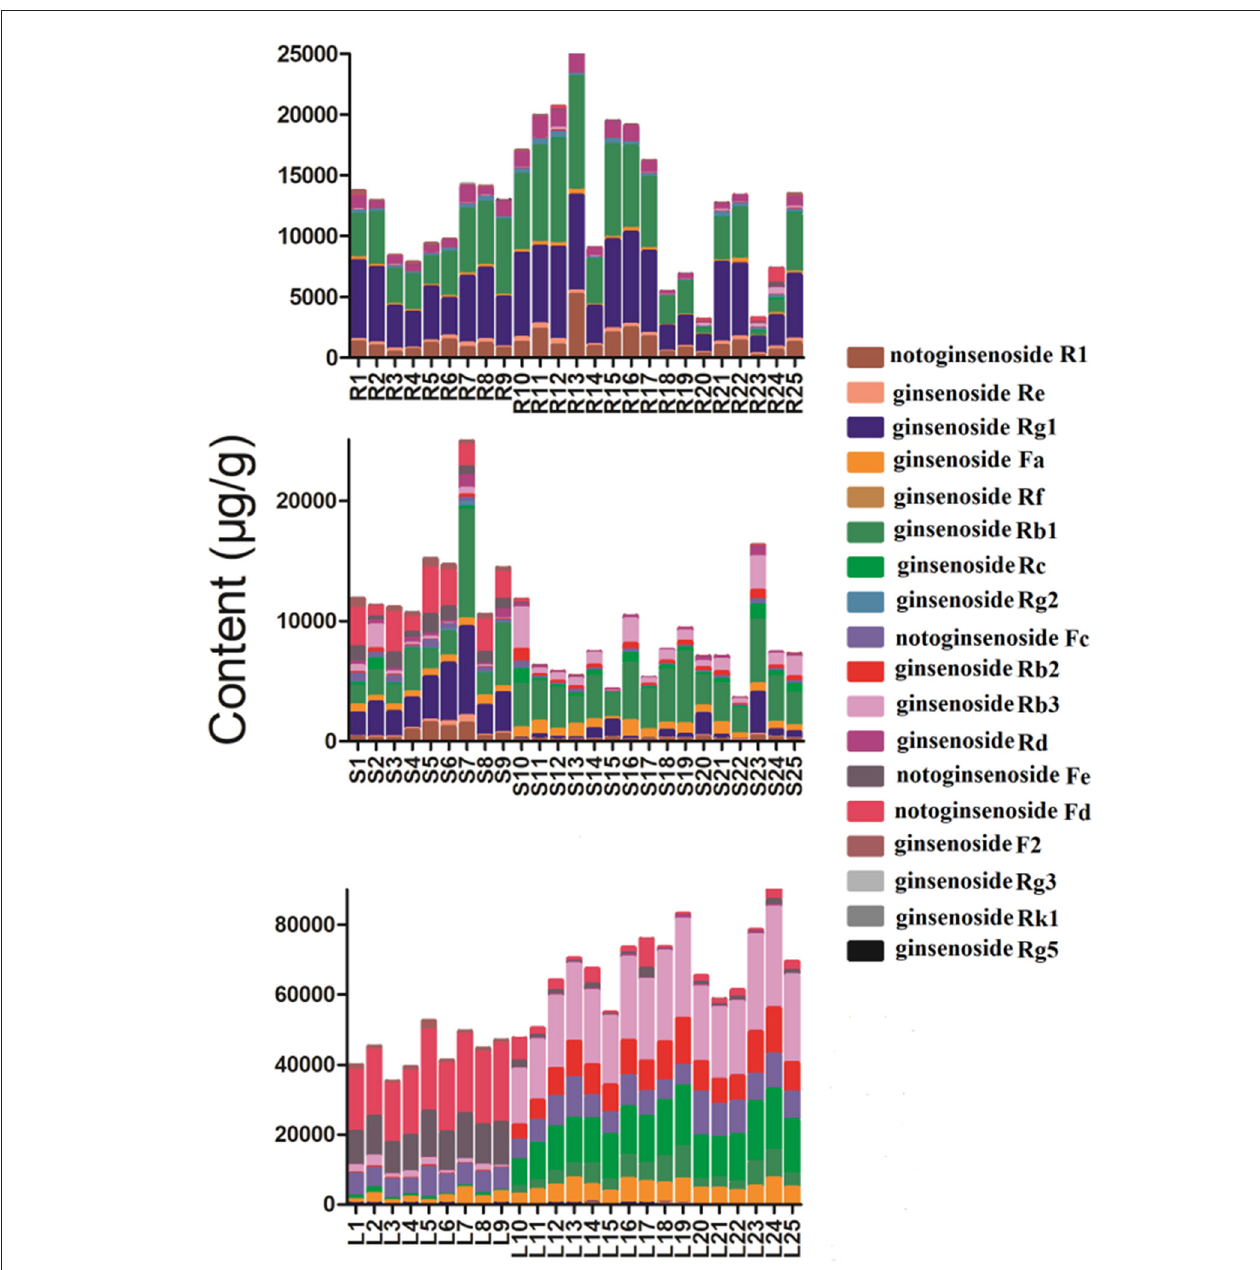
FIGURE 1 | The total contents of 18 saponins in different parts of P. notoginseng from different batches (R, Root; S, Stem; L, Leaf).